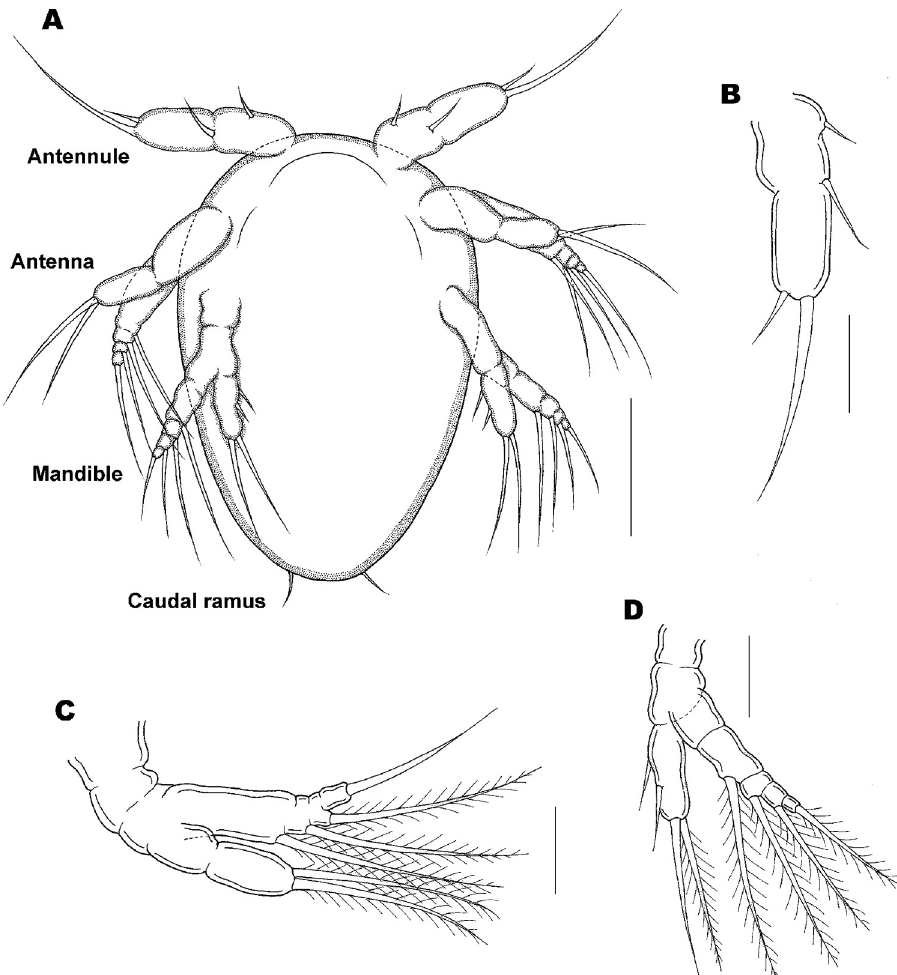
Fig 4. Nauplius stage I of Ive ptychoderae . (A) Habitus, ventral; (B) Antennule; (C) Antenna; (D) Mandible. Scale bars: A = 0.05 mm; B–D = 0.025 mm. and distal part with 1 slender claw and 1 longest seta. Labrum as in CI. Mandible, maxillule, and maxilliped not present. Legs 1–5 as in the previous stage. Copepodid III Fig 8. Body (Fig 8A) moderately slender. Average length 218 (206–228) μ m and greatest width 73 (70–75) μ m based on 9 specimens. Segmentation of body indistinct. Caudal ramus (Fig 8A and 8B) elongated, bearing 1 terminal longest seta (= innermost terminal seta in the previous stages), and 2 inner, marginal setae in addition to 2 setae on outer-lateral margin. Antennule (Fig 8C and 8D) 4-segmented, setal formula: 6, 4, 3, and 3+1 aesthetasc. Antenna (Fig 8C and 8E) 2-segmented, basal segment largest, bearing patch of spinules on middle mar- gin, second segment with 1 long seta with lamella, 2 small spiniform setae, and 2 claws. Labrum (Fig 8C) projected posteriorly at both free corners. Mandible, maxillule, and maxil- liped not present. Legs 1 and 2 (Fig 8F and 8G) biramous, with 1-segmented exopod and endopod. Formula of spines (in Roman numerals) and setae (in Arabic numerals) as follows: